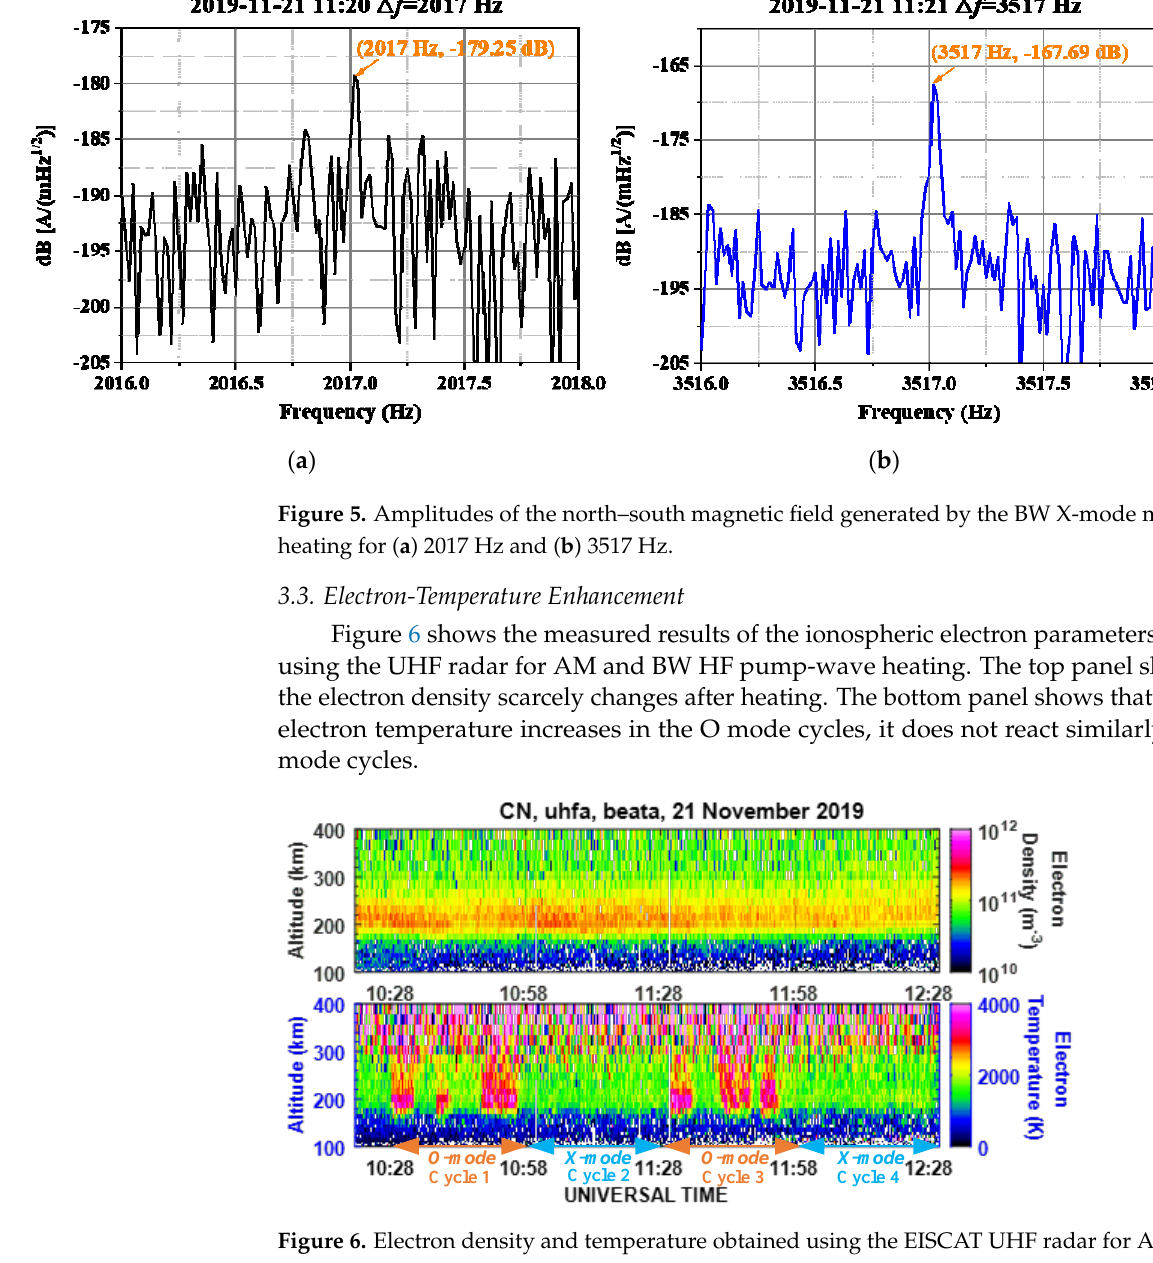
Figure 6. Electron density and temperature obtained using the EISCAT UHF radar for AM and BW modulation heating. modulation